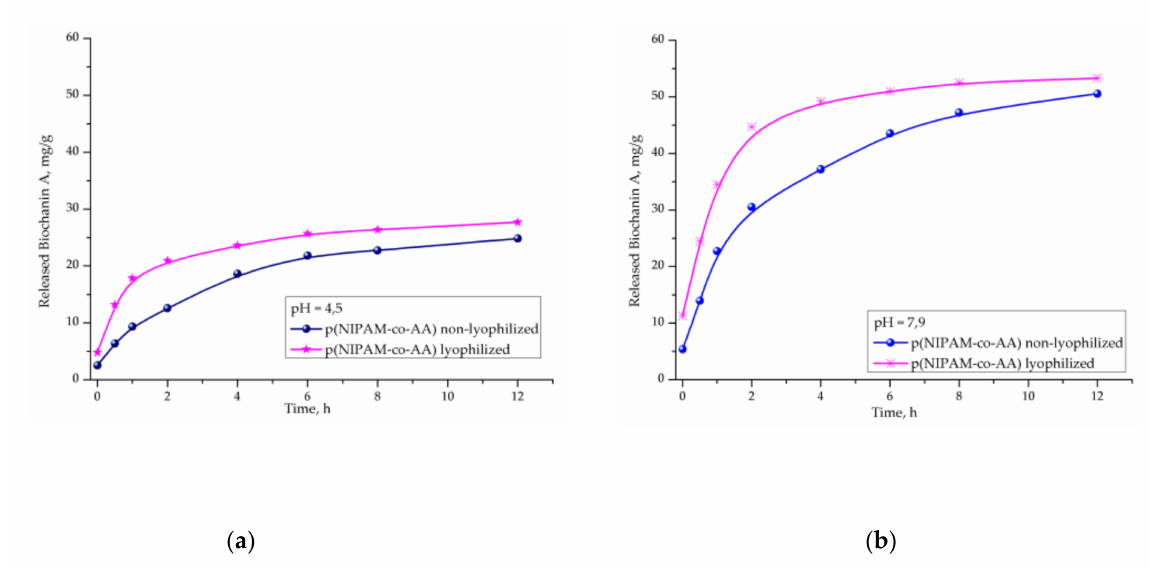
Figure 15. Released biochanin A content at 37 ◦ C from non-lyophilized and lyophilized poly( N -isopropylacrylamide-co- acrylic acid), p(NIPAM-co-AA), copolymers, at: ( a ) pH = 4.5 and ( b ) pH =